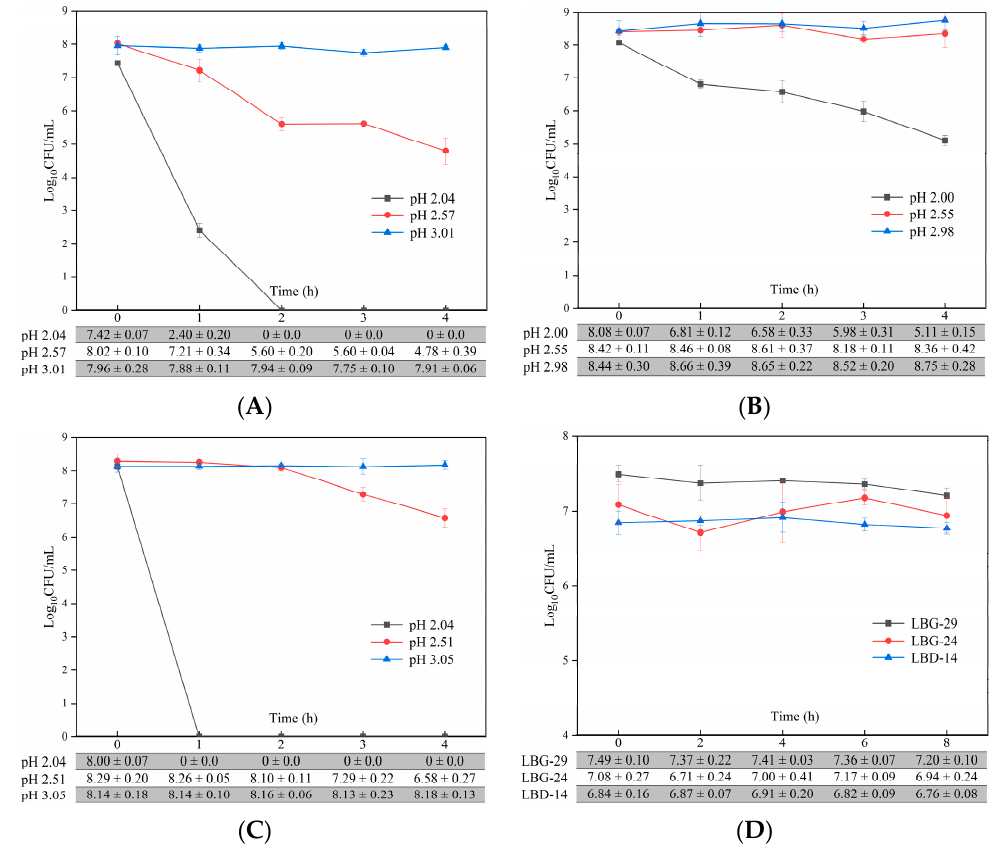
Figure 2. Tolerance of the three Levilactobacillus brevis strains to simulated gastric acid and bile salts in vitro. ( A – C ) Tolerance of LBG–29 ( A ), LBG–24 ( B ), and LBD–14 ( C ) to simulated gastric acid in vitro. ( D ) Tolerance of LBG–29, LBG–24, and LBD–14 to simulated intestinal bile salts (3 g/L) in vitro. Values are means ± SD.